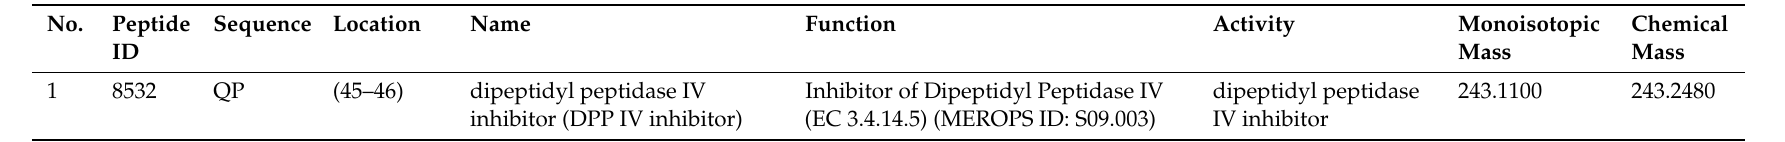
Table A11. Bioactive peptides from RubisCO of Halophila stipulacea . In silico enzymatic cleavage was carried out by using prolyl oligopeptidase.